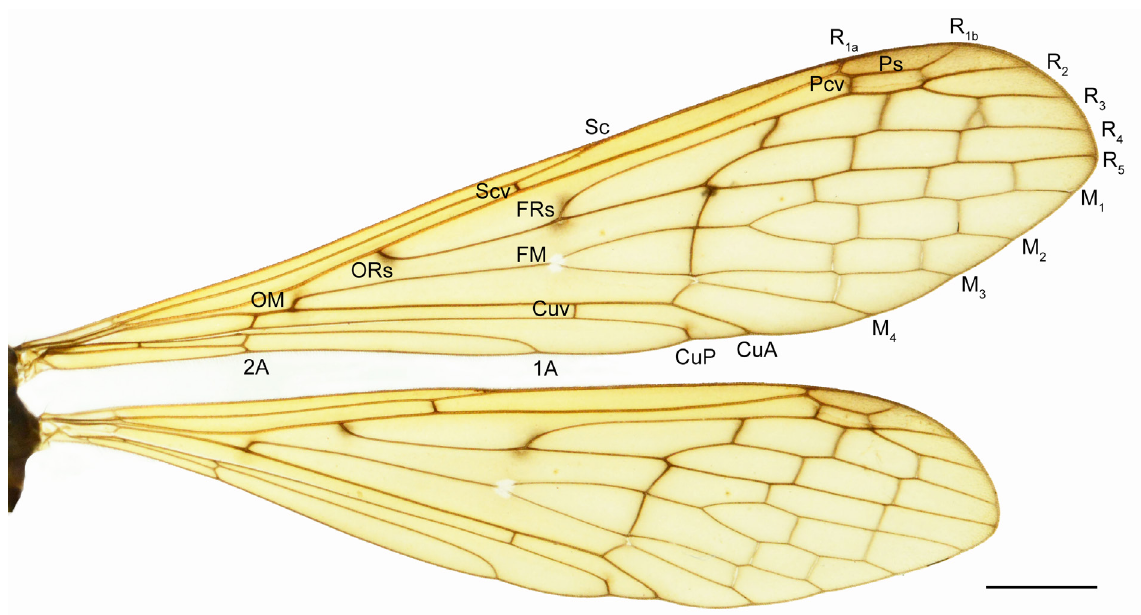
Fig. 3. Right wings of Bittacus dilobus sp. nov., ♂, holotype (NWAU). Abbreviations: see Material and methods. Scale bar = 2.0